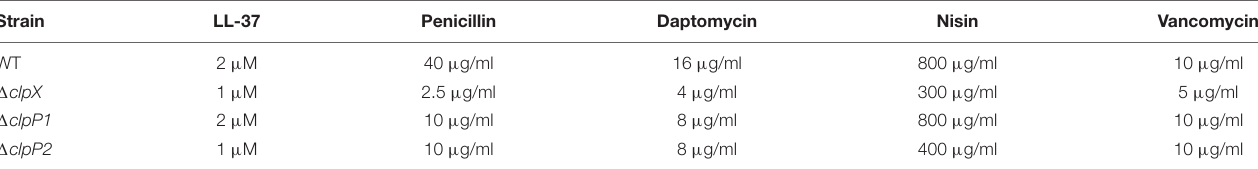
FIGURE 3 | Both clpP1 and clpP2 genes contribute to antimicrobial resistance. Overnight growth of wild-type B. anthracis Sterne (WT), (cid:49) clpP1 or (cid:49) clpP2 containing the empty inducible plasmid (pUTE657), and (cid:49) clpP1 or (cid:49) clpP2 complemented with either the wild-type clpP1 (p clpP1 ) or clpP2 (p clpP2 ) genes in media containing (A,B) LL-37, (C,D) daptomycin or (E,F) penicillin. Data are presented as mean ± SD and assays were repeated at least 3 independent times. Statistical significance determined by a one-way ANOVA followed by Tukey-Kramer post hoc test; * p < 0.05; ** p < 0.01; *** p < 0.001 or non-significant (ns) from WT levels within each treatment group. TABLE 2 | MICs of wild-type B. anthracis Sterne and the (cid:49) clpX, (cid:49) clpP1, and (cid:49) clpP2 mutants. Strain LL-37 Penicillin Daptomycin Nisin